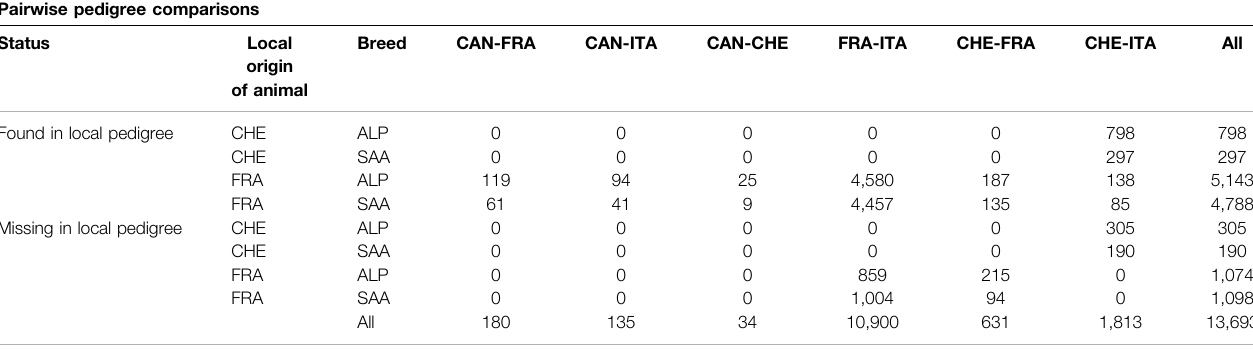
TABLE 2 | Pedigree connectedness for Alpine and Saanen populations between pairs of four countries. Country abbreviations are CAN for Canada, CHE for Switzerland, FRAforFrance,andITAforItaly.Thenativecountryisprovidedineachanimal ’ sname;itispossibletocheckifaforeignanimalinapedigreeisfoundinitsnativepedigree (found in local pedigree) or not (missing in local pedigree).